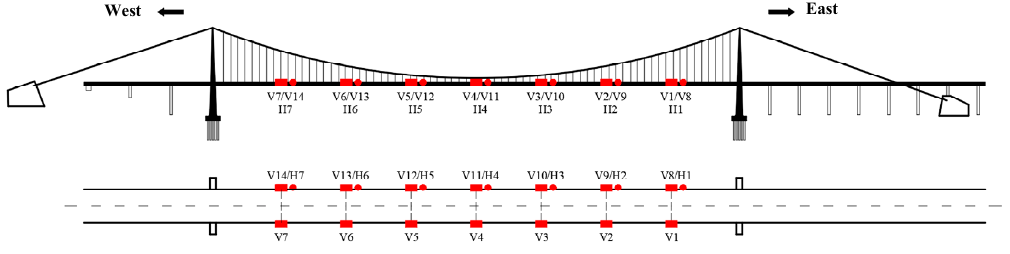
Figure 5. Accelerometer sensor layout on Humen Bridge.